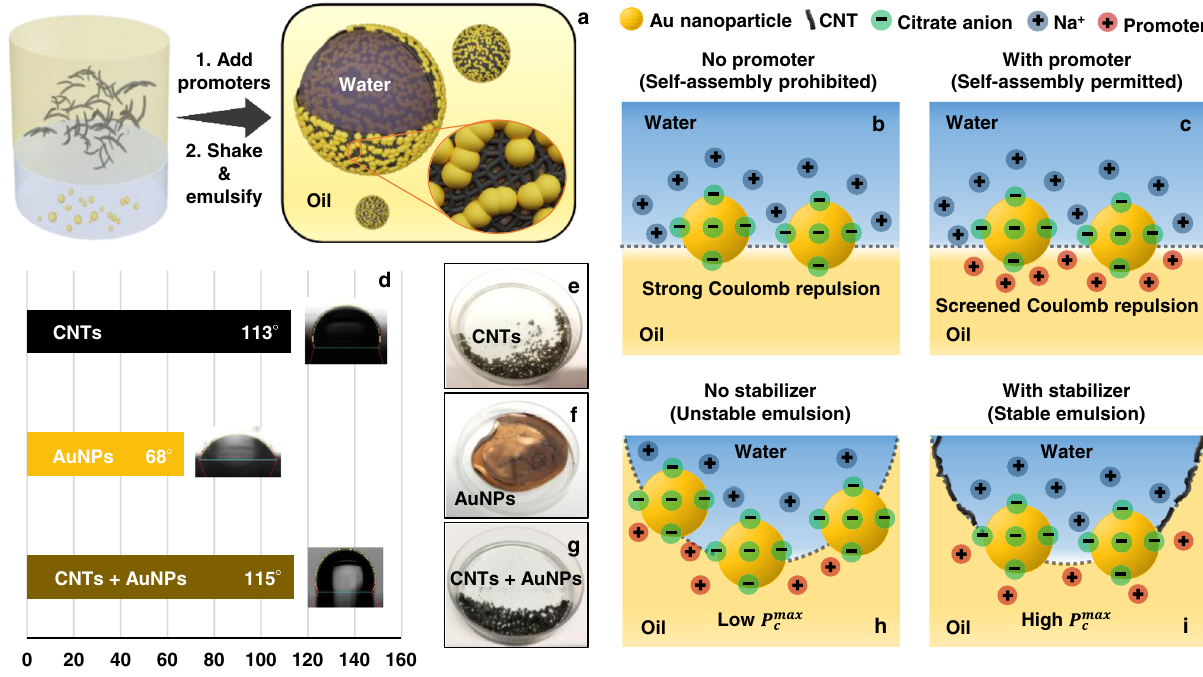
Fig. 1 | Workingprinciplesofstabilizersand promotersin plasmonicPickering emulsions. a Schematic illustration of the experimental process for generating carbon nanotube (CNT)-Au nanoparticle (AuNP) stabilized w/o emulsions. b Schematic illustrations of charged AuNPs repelling each other at the interface. c Schematic illustrations of the working principle of organo-electrolytes acting as “ promoters ” for interfacial self-assembly by providing charge-screening. d Three-